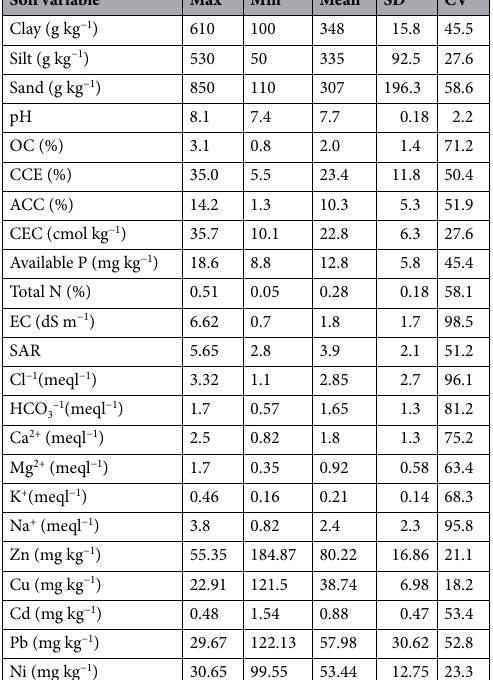
Table 2. Summary statistics of selected attributes and heavy metals in the urban soils. OC organic carbon, CCE calcium carbonate equivalent, ACC active calcium carbonate, CEC cation exchange capacity, EC electrical conductivity, SAR sodium adsorption